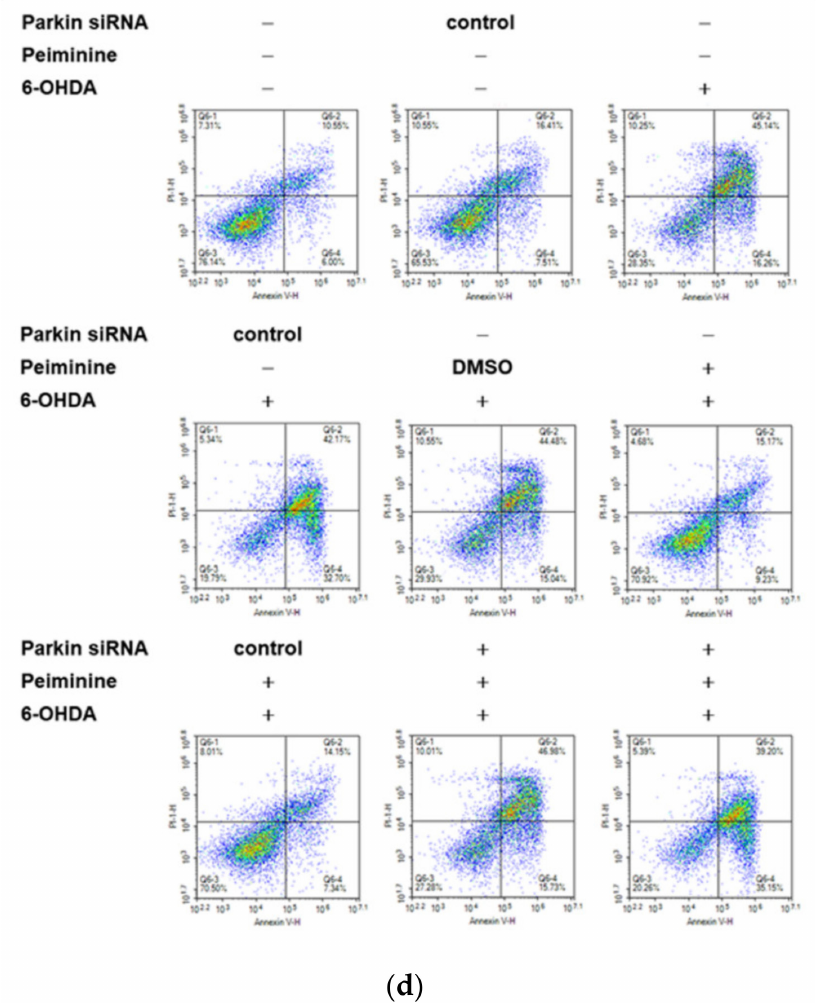
Figure 9. Down-regulation of parkin by RNAi can reverse the anti-apoptotic effect of peiminine (PMN) in 6-hydroxydopamine (6-OHDA)-exposed SH-SY5Y cells. SH-SY5Y cells were transfected with control siRNA or parkin siRNA for 24 h, and then the transfected cells were treated with 1 µ M PMN or no treatment, respectively. After 24 h, cells were exposed to 100 µ M 6-OHDA for 18 h. ( a ) DiOC6 (1 µ M) staining was used to evaluate damage to mitochondrial membrane potential (MMP). The representative fluorescence images of each group are shown here. ( b ) Hoechst 33258 (5 µ g/mL) staining was used to evaluate the ratio of nuclear condensation. The representative fluorescence images of each group are shown here. ( c ) ImageJ software was employed to analyze the fluorescence intensity of the staining in ( a ) and ( b ). The relative fluorescence intensity is indicated as a ratio relative to the control group. ( d ) Flow cytometric analysis of Annexin-V-FITC and PI staining was implemented on each group. Apoptosis rate = percentage of early apoptotic cells in the lower right quadrant + percentage of late apoptotic cells in the upper right quadrant. The results shown above are the standard errors of the average of three independent experiments. # Indicates a significant difference between the 6-OHDA-exposed group and the control group ( ### p < 0.001). * Indicates a significant difference between the PMN-pretreated 6-OHDA-exposed group and the PMN-untreated 6-OHDA-exposed group (** p < 0.01, *** p <